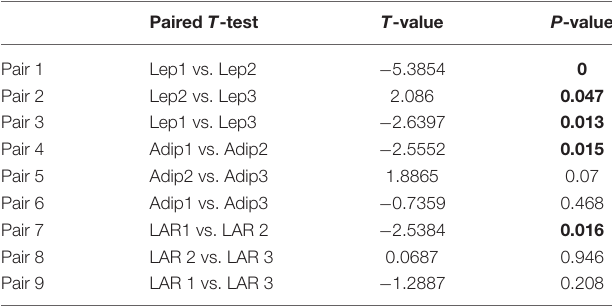
TABLE 5 | Comparison of Leptin and Adiponectin marrow levels at different